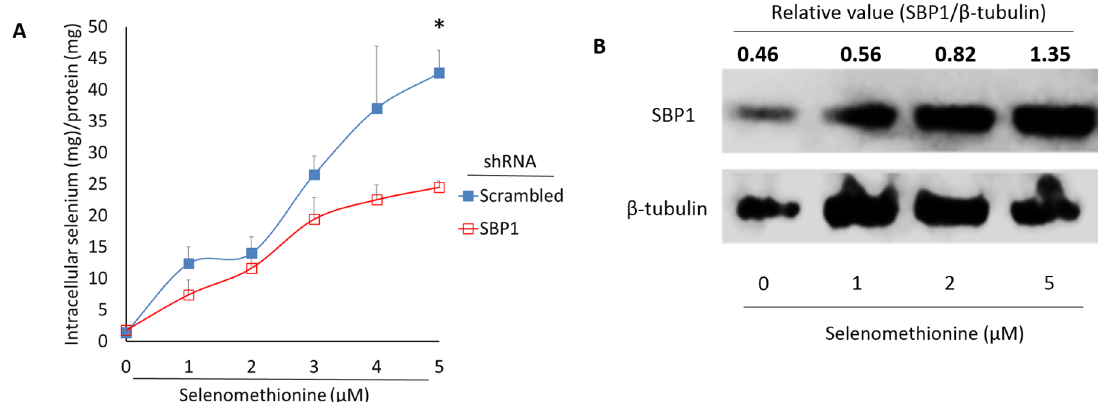
Fig 3. Increased SBP1 protein levels and SBP1-dependent retention of intracellular selenium content after selenomethionine treatment in HeLa cells. (A) Intracellular selenium concentration was determined in scrambled and SBP1 shRNA HeLa cells treated with a gradient concentration of selenomethionine (0 – 5 μ M, 3 h). Values are means ± SEM (n = 3). * , p < 0.05, compared to SBP1 shRNA HeLa cells. (B) Western analyses of SBP1 and β -tubulin in HeLa cells treated with a gradient concentration of selenomethionine (0 – 5 μ M, 24